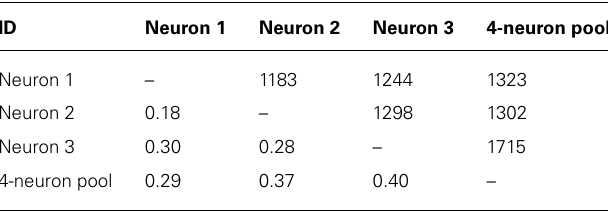
Table 2 | Pairwise Spearman’s rank correlation coefficient for between all live neurons from brain slice. ID